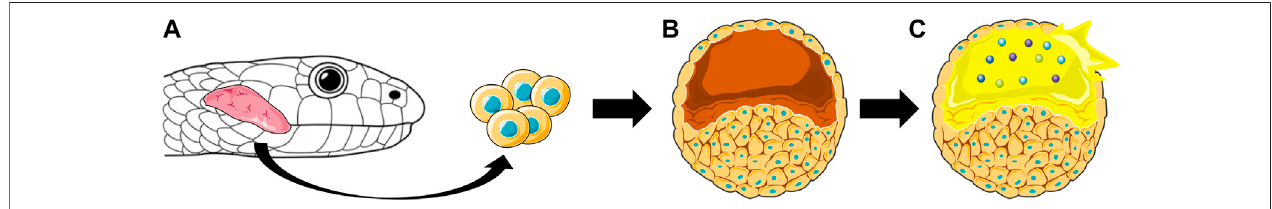
FIGURE 7 | Representation of how venom gland organoids are derived from snake venom gland cells. The cells isolated from the snake venom glands (A) are cultured as organoids (B) that secrete venom (yellow) containing active toxins (spheres), which can be isolated from the organoids (C) .